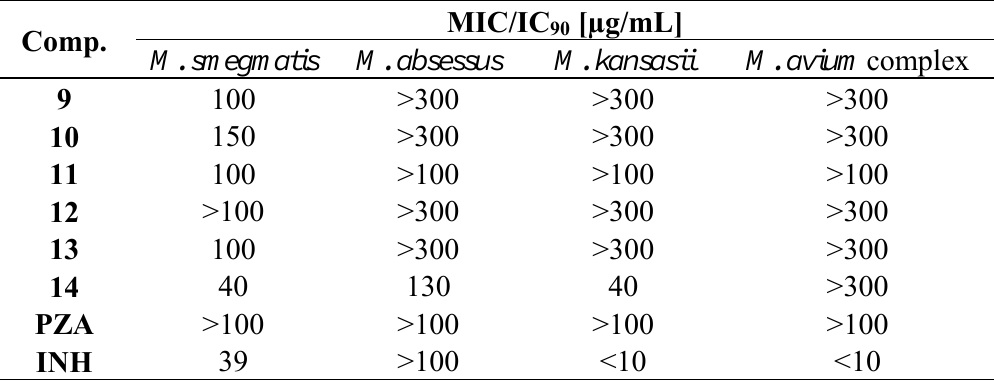
[µg/mL] of compounds 9 - 14 in comparison 90